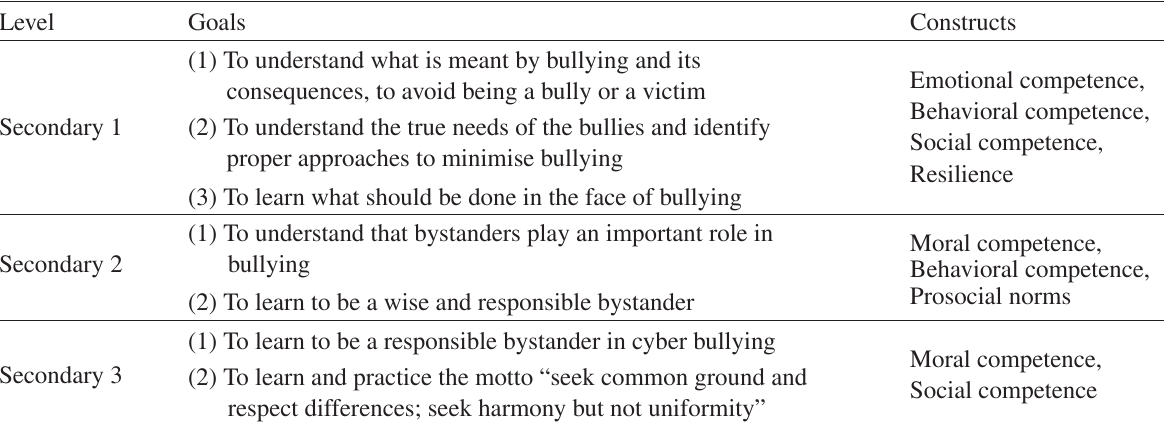
TABLE 1: An overview on the foci of the P.A.T.H.S. units on